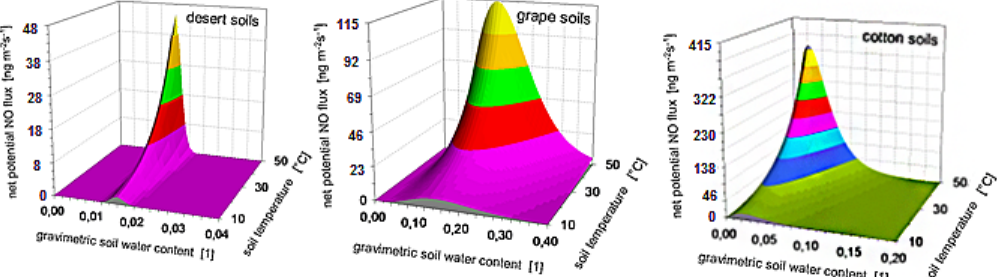
Figure 4. Results of laboratory incubation measurements on soil samples of the Tohsun Oasis taken in 2010: the net potential NO fluxes F NO (ngm − 2 s − 1 , in terms of mass of N) from the three major land use types of the Tohsun Oasis (desert, grape, and cotton soils) are shown as functions of soil temperature and the gravimetric soil moisture content. The soil samples were taken in 2010. Note the different scales of net potential NO fluxes and the gravimetric soil water content.